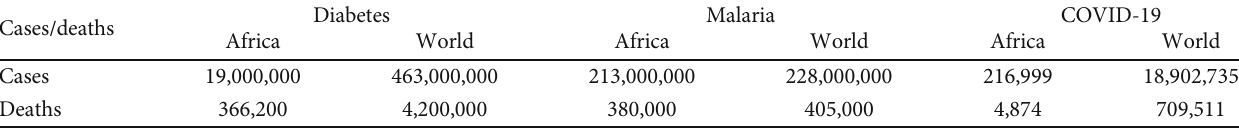
Table 1: Total cases and deaths from COVID-19, diabetes, and malaria in Africa and the world.